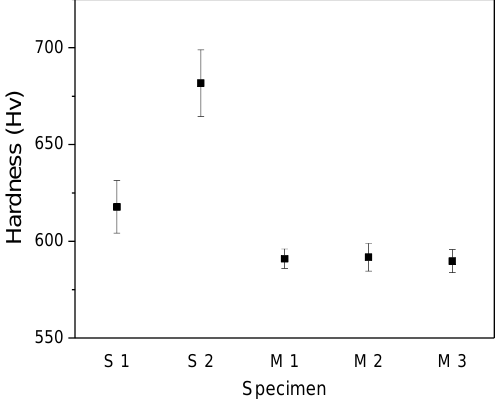
Figure 4. Hardness of the coil spring specimens.